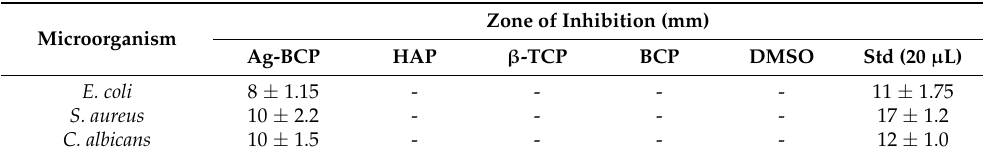
Figure 13. Antimicrobial investigation against ( a ) S. aureus , ( b ) E. coli , and ( c ) C. albicans (where 1. Ag-BCP, 2. HAP, 3. B-TCP, 4. BCP, 5. DMSO, and 6. Standard). Table 3. Zone of inhibition (mm) data of bioceramic samples treated against E. coli , S. aureus , and C. albicans